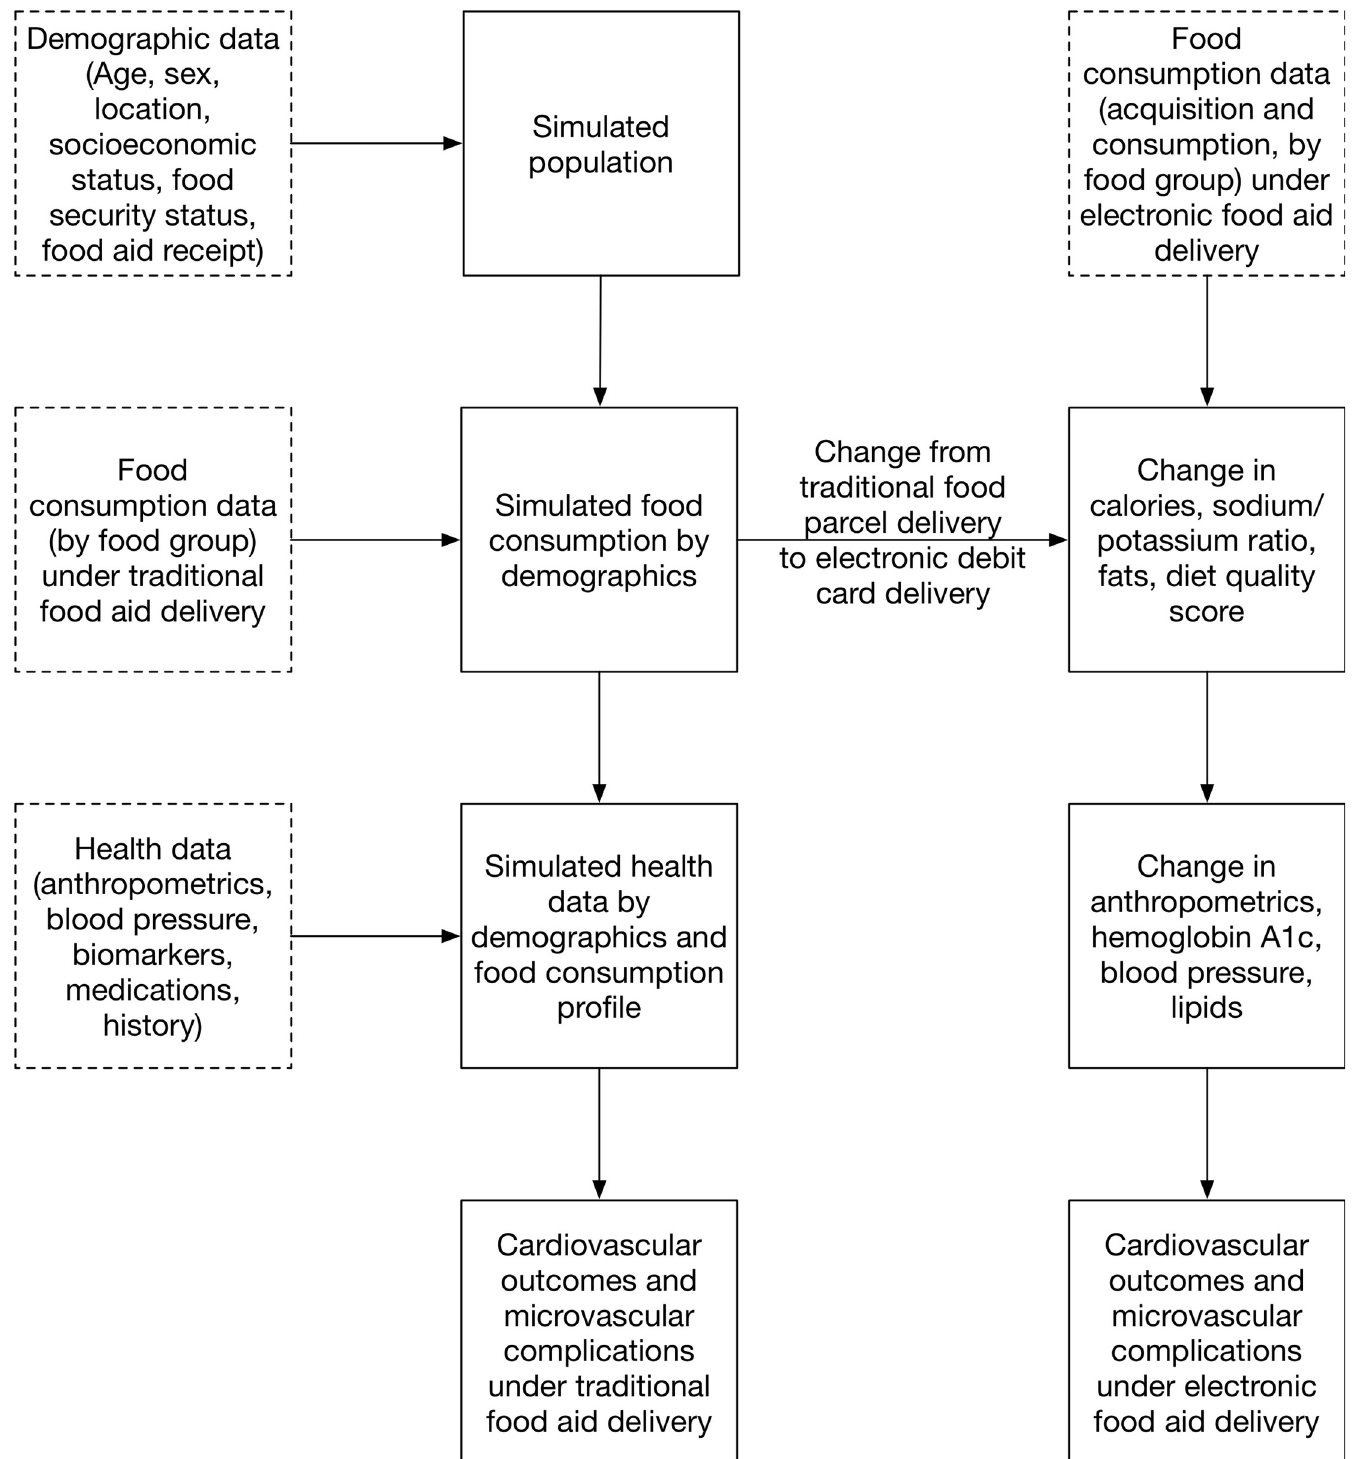
Fig 1. Model diagram. Data are in dashed squares and simulation steps in solid squares. See Tables 1 and 2 for data sources and parameter values.